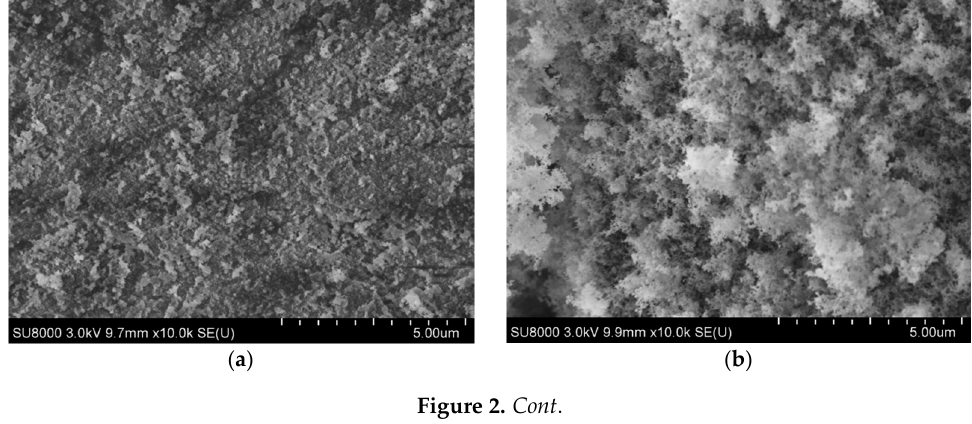
Table 6. Physical parameter of BA, SBA, OCSSBA, SOCSBA, and SCASBA before and after rolling thin film oven (RTFO)